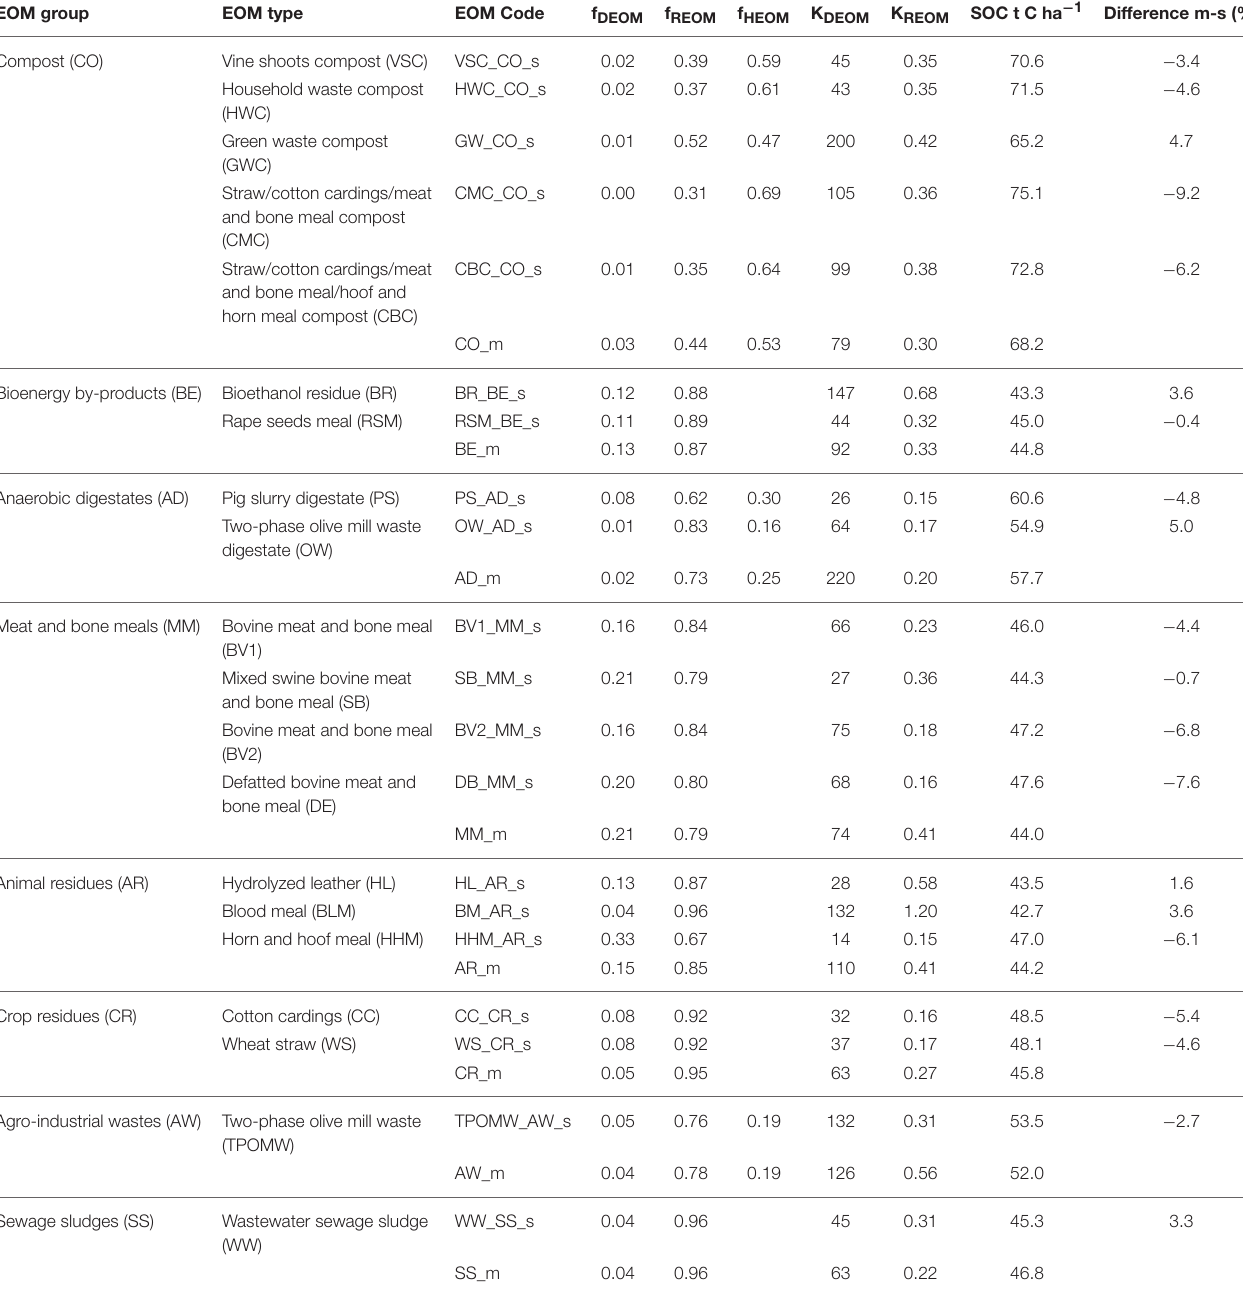
TABLE 1 | Results of RothC generality test: simulation of 100 years of amendment utilizing EOM-type and EOM-group pool parameters. EOM